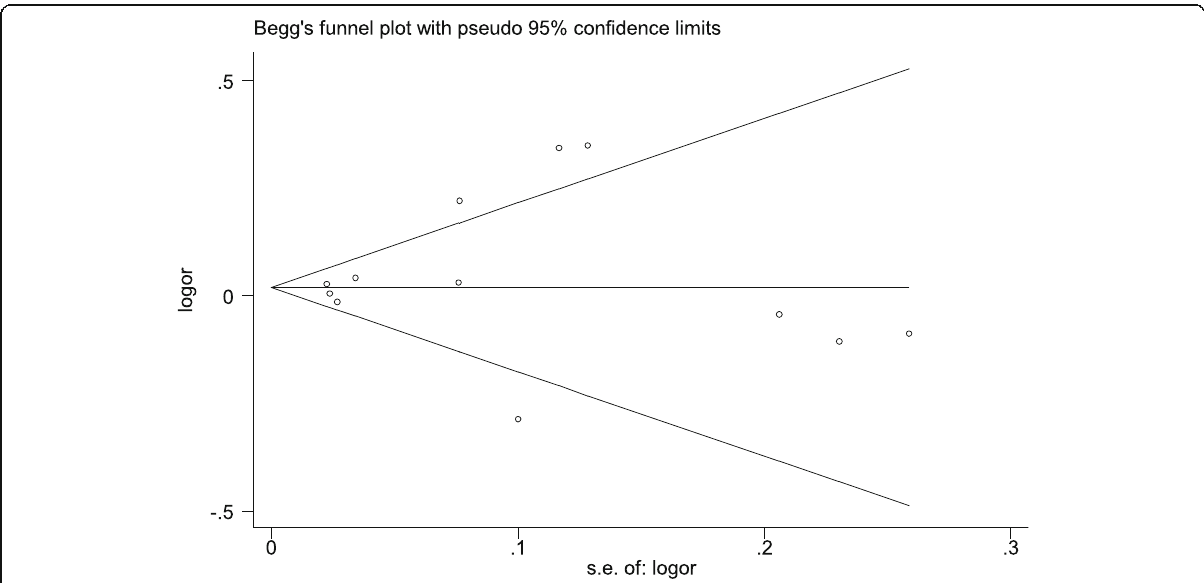
Fig. 5 Begg ’ s funnel plot. The funnel plot suggested absent of publication bias among the eligible